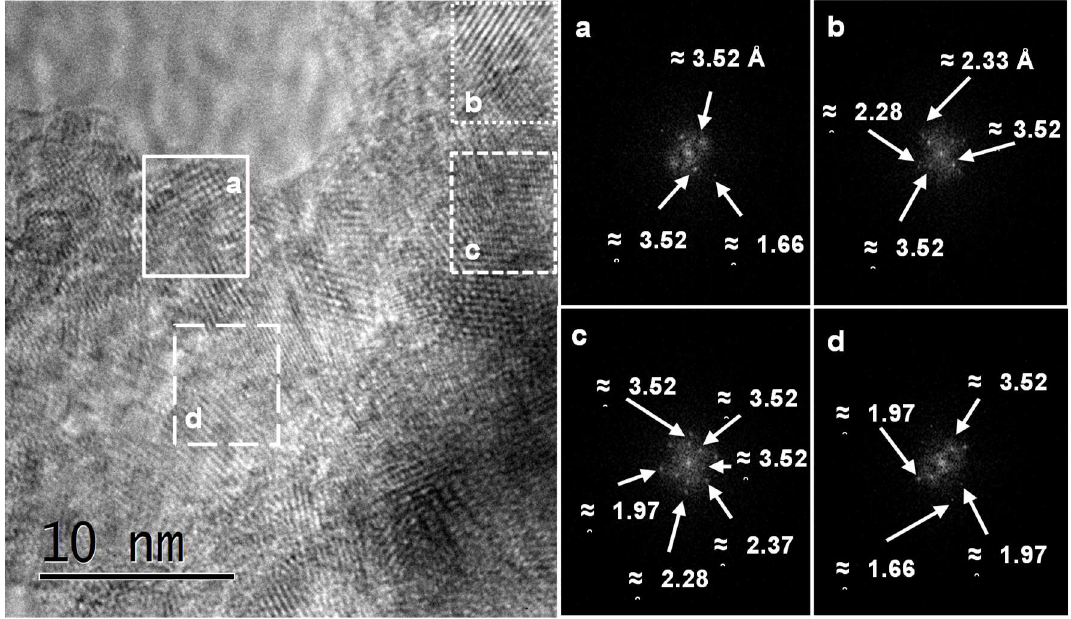
Figure 6. High-resolution micrograph (HRTEM) and fast Fourier transform (FFT) of the respective scanned area ( a – d ) for the AT600 catalyst calcined at 600 °C. scanned area ( a – d ) for the AT600 catalyst calcined at 600 ◦